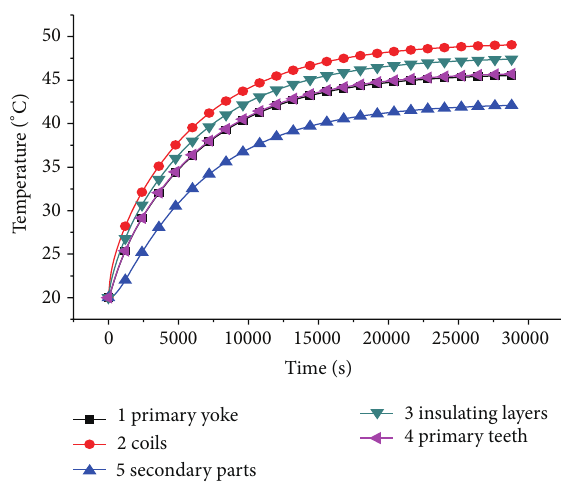
Figure 9: Each part temperature rising curve of the new secondary structure TPMLWG.